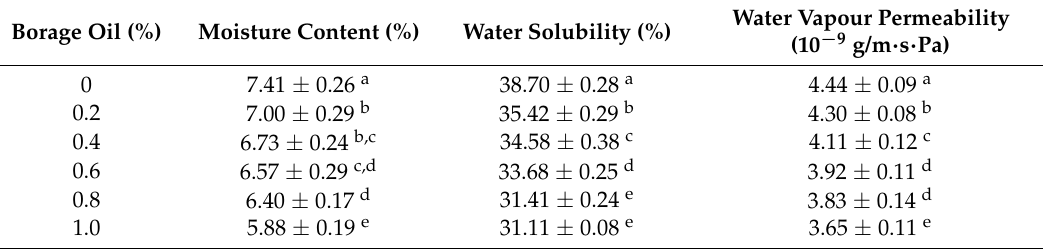
Table 2. Moisture content, water solubility, and water vapor permeability of the BMS films containing BO.